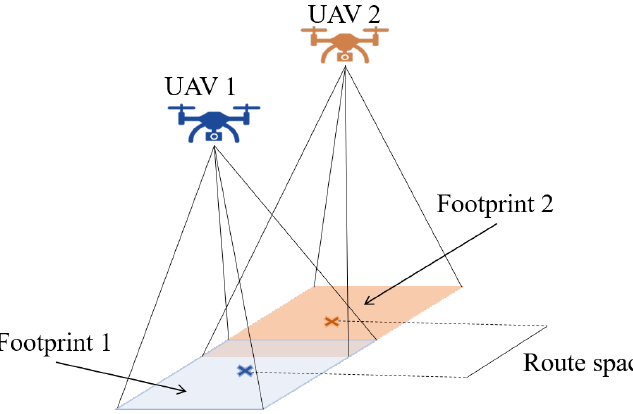
Figure 1. Footprint schema in a homogeneous UAV fleet.